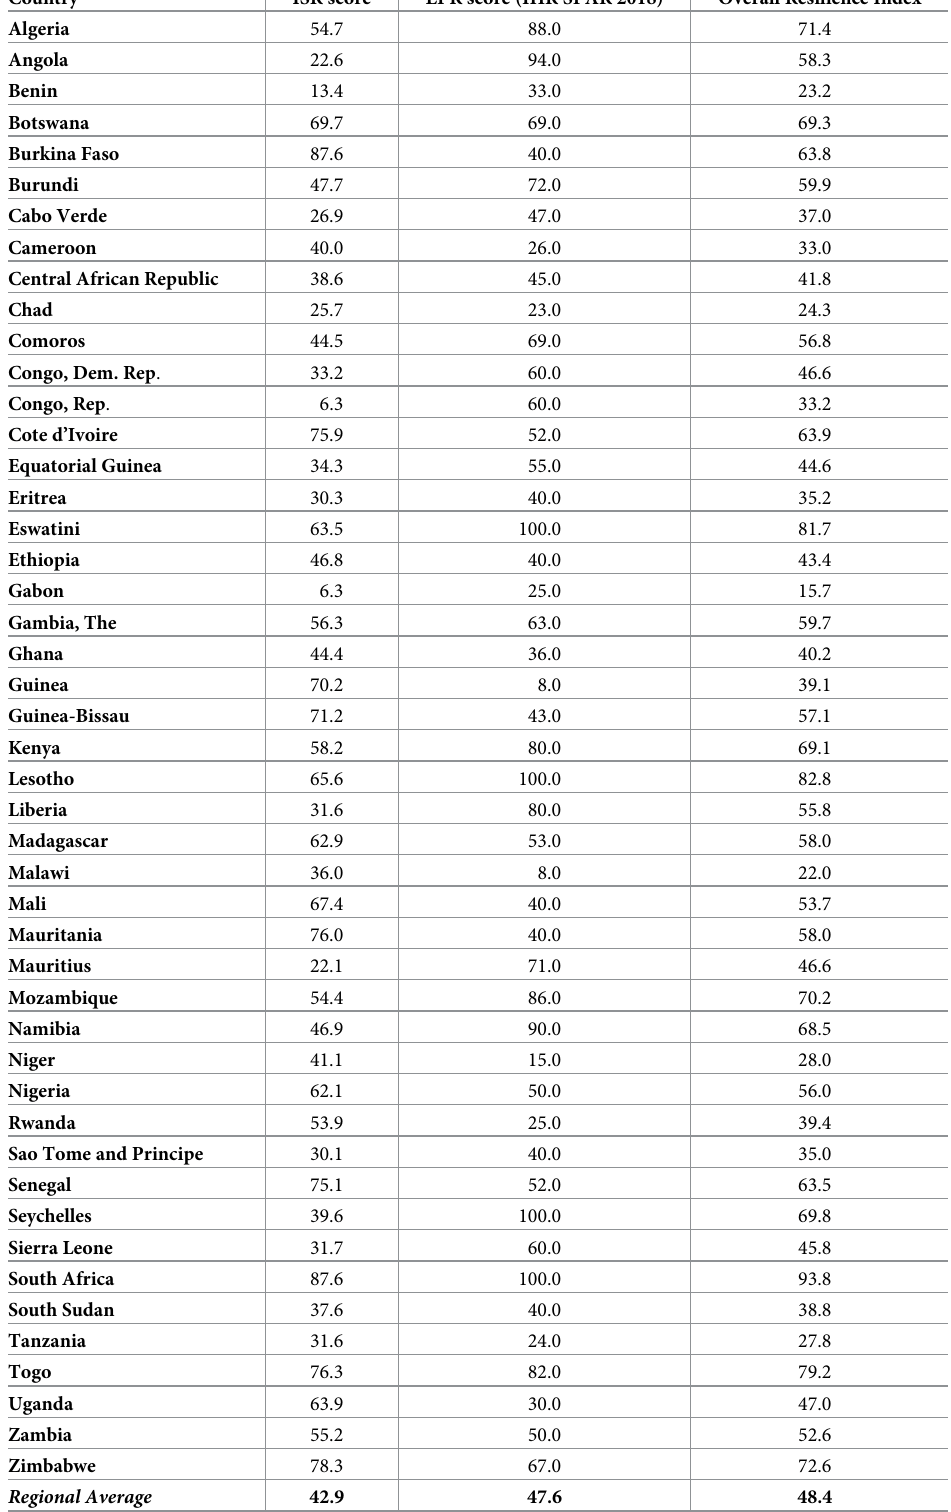
Table 3. Country specific values of overall resilience index and contribution of inherent system resilience and emergency preparedness and response